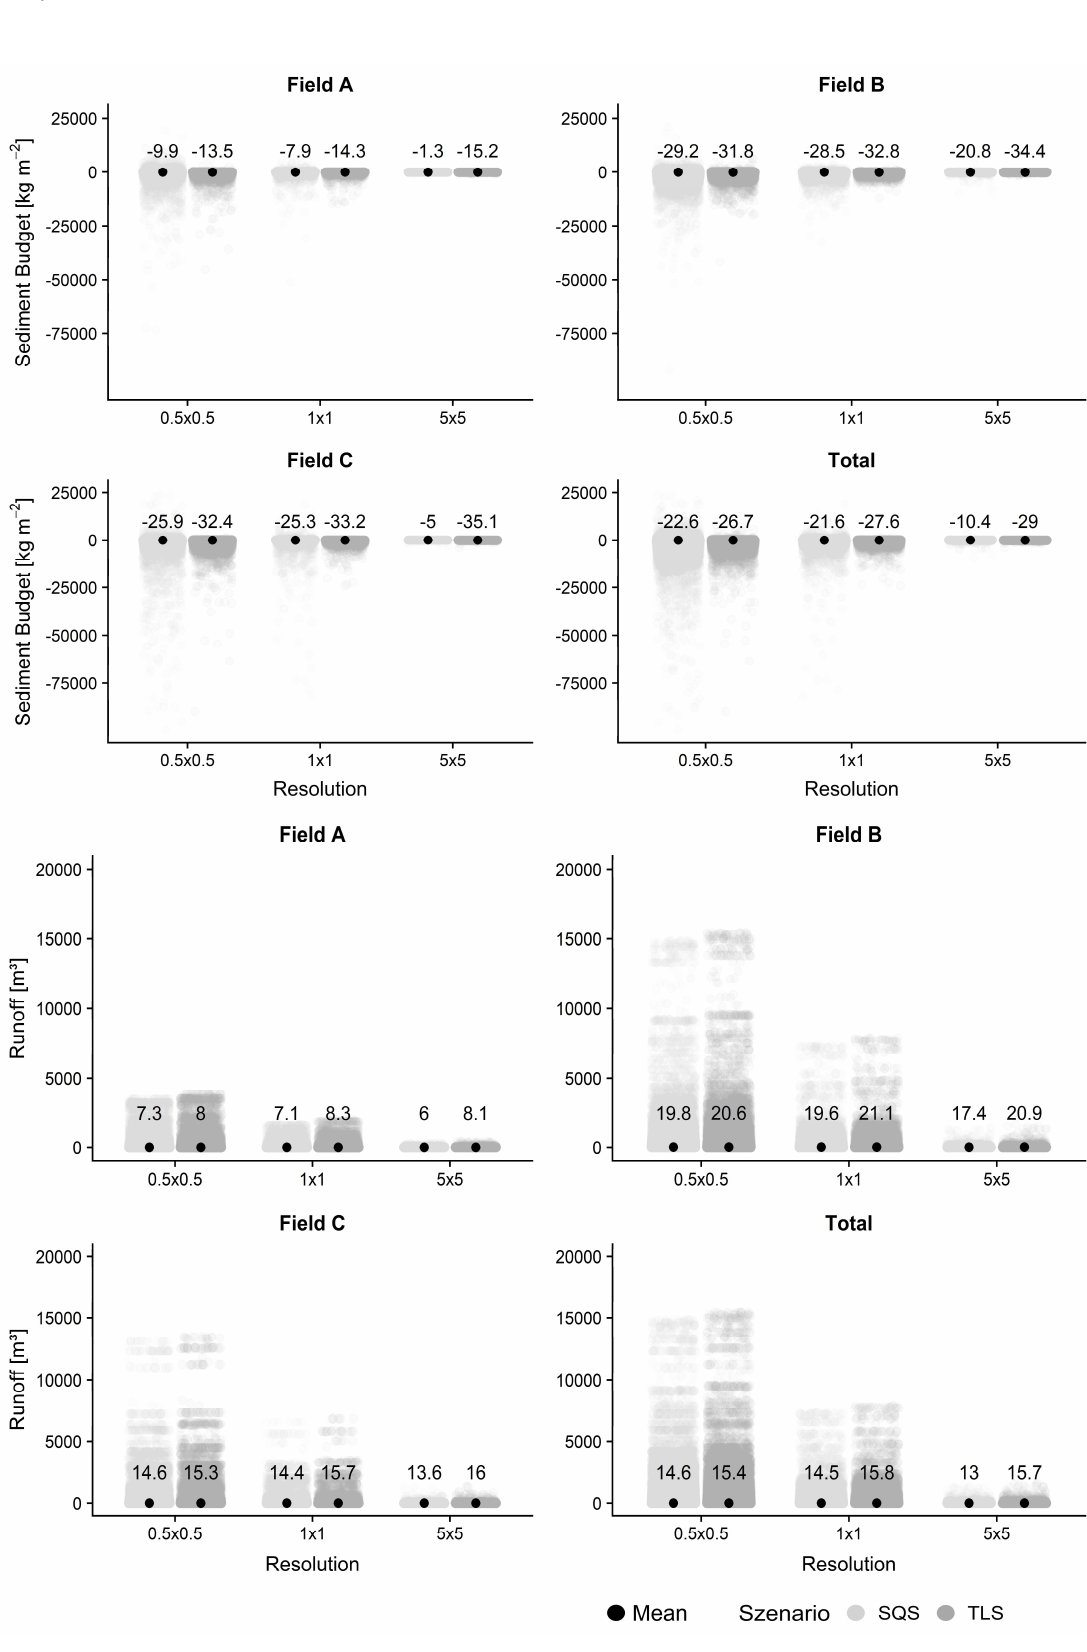
Figure 5. Density plots of sediment budget (top) and runoff (bottom) grouped by field, scenario and resolution for Status-Quo-Scenario (SQS) and Tramline-Scenario (TLS). Each point in the plot represents a simulated cell value from the output-raster of E3D. Mean soil loss for field B increased less from 28.5 to 32.8 ± 163.8 kg m −2 , while field C exceeded soil loss rates of field B to 33.2 ± 283.2 kg m −2 (25.3%). For field A, soil loss rates were nearly doubled